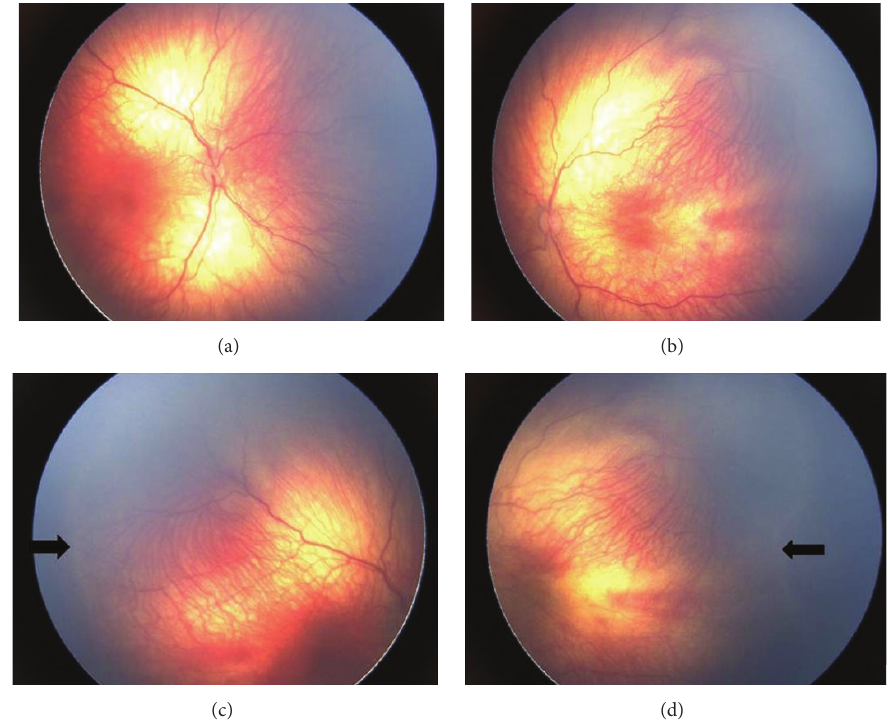
Figure 1: Minimal vascular tortuosity is observed in both eyes (a and b). The arrows indicate the demarcation line in Zone II along the tem- poral region in both eyes (c and